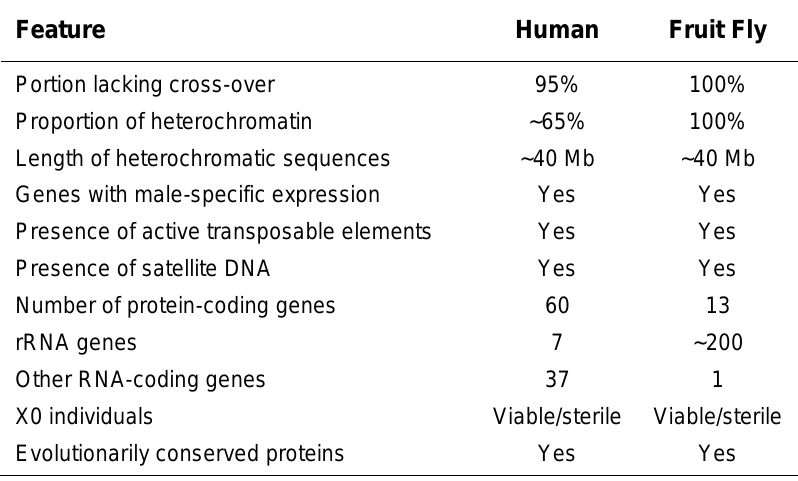
Similarities between Fly and Human Y